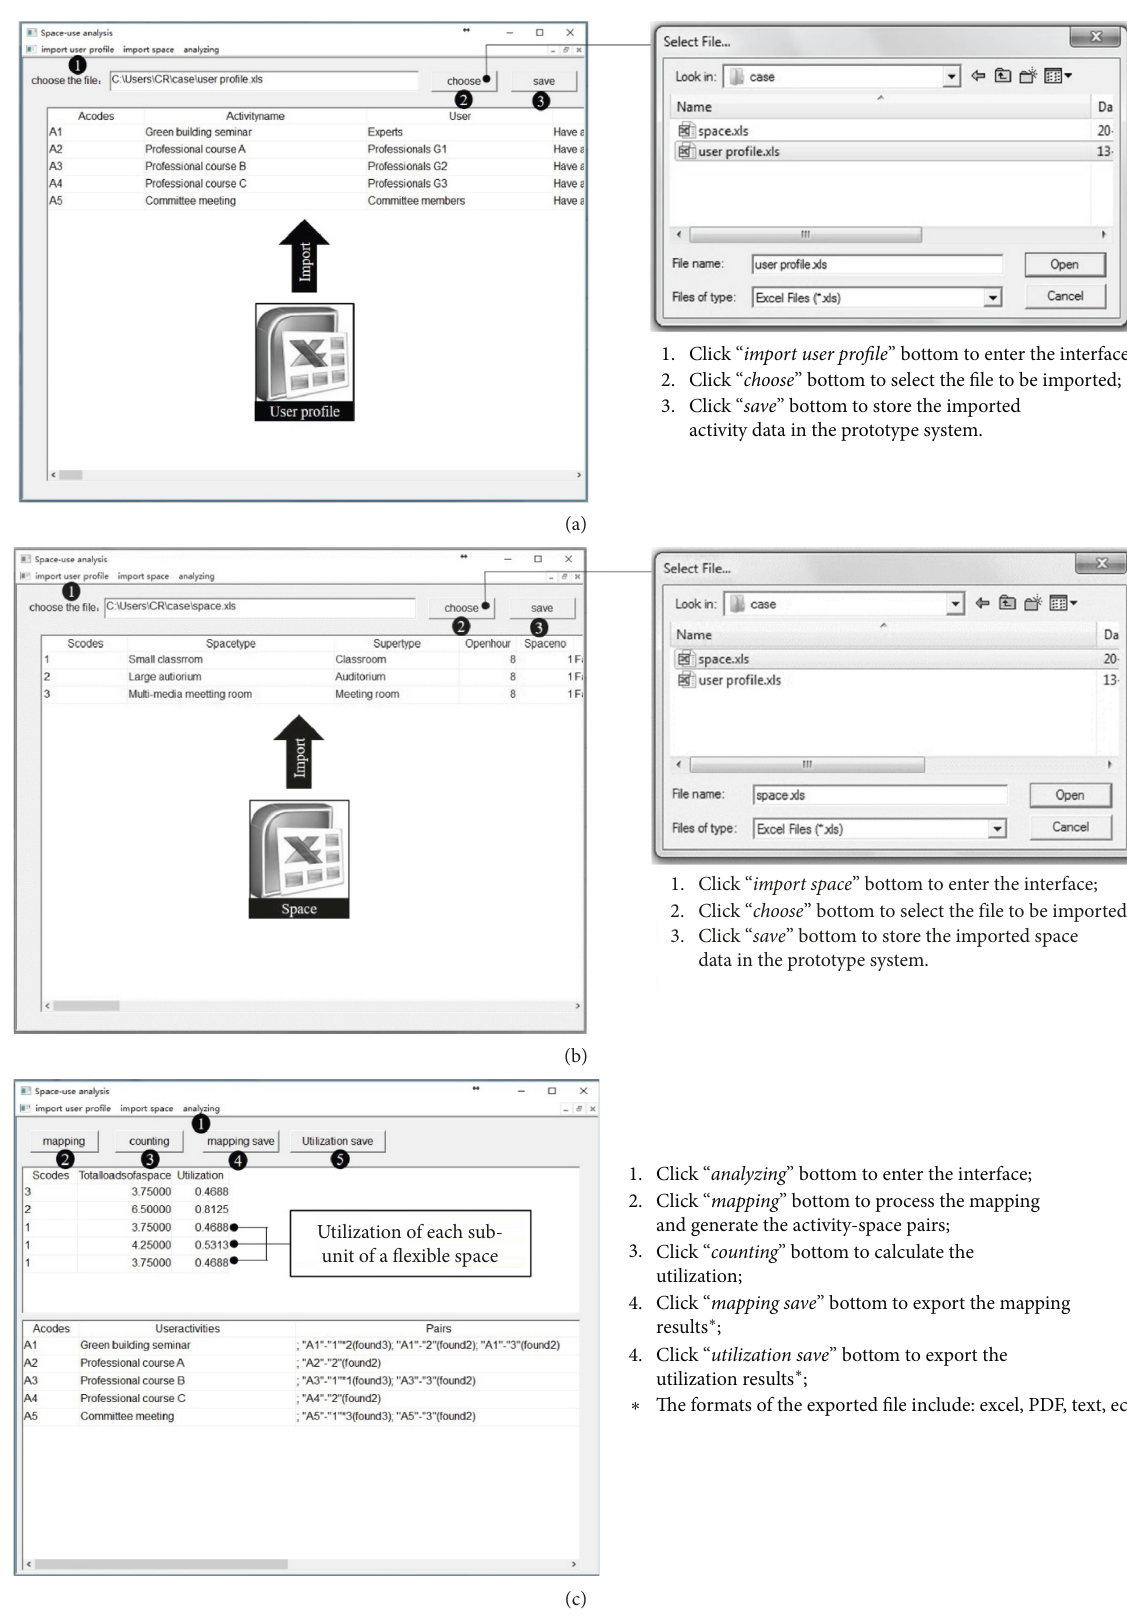
Figure 3: Prototype system for an automated SUA. (a) Import activity information. (b) Import space information. (c) Mapping and computing